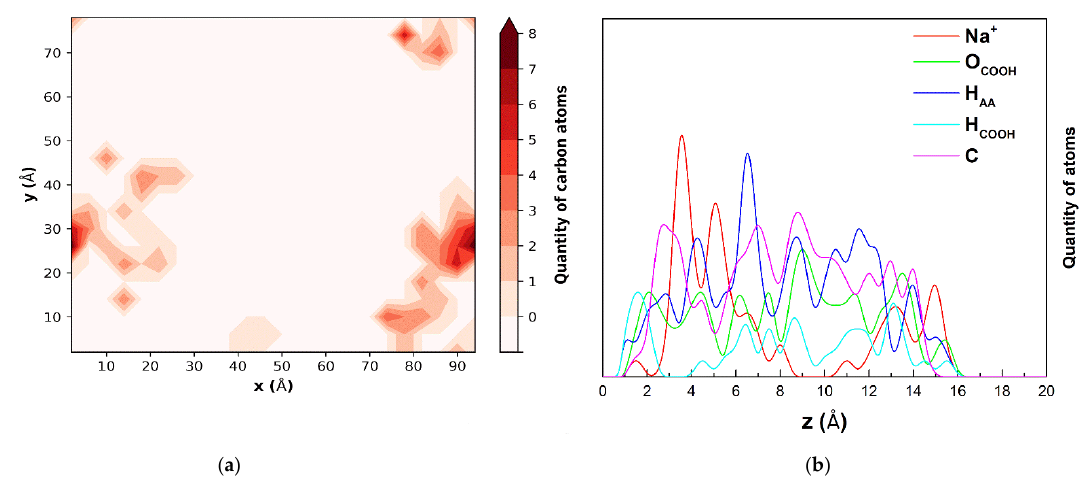
Figure 3. ( a ) Carbon quantity contour maps on the xy-plane parallel to the montmorillonite layer and ( b ) the quantity of Na + , O COOH (O atoms in COOH group), H AA (H connected to C in acrylic acid), H COOH (H atoms in COOH group), and C (C in acrylic acid) as a function of distance from the montmorillonite layer surface for 36.35, 52.90, and 63.00 ps after adding acrylic acid. The simulations showed that acrylate anions do not tend to group. Carbon quantity contour maps (Figure 4a) show the scattered groupings of carbon atoms that correspond to single acrylate anions. There is a maximum of 3 carbon atoms. Na + cations are nearest to the montmorillonite surface (Figure 4b). Only at above 4 Å from the surface do the atoms building acrylate anions begin to appear. Figure 3b shows neither sodium nor the atoms building acrylate ions grouped close to the surface. Both Na + and acrylate anions are present far from the surface, above 20 Å in the bulk of the water, as well as a short distance from the surface. The presence of sodium cations far from the surface is due to the presentence of CH 2 =CHCOO − balancing the charge of Na + .